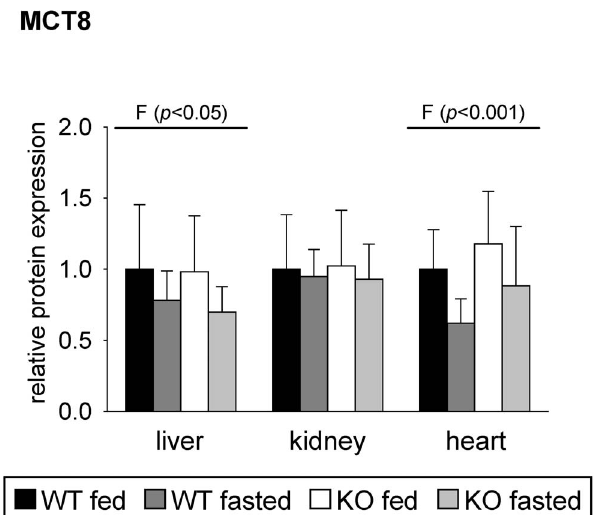
Figure 6. Relative protein expression of monocarboxylate transporter (MCT)-8 in mouse tissues in response to fasting and PPAR a . Values represent means 6 SD of relative protein expression of wildtype (WT) and PPAR a knockout (KO) mice that were fed ad libitum or fasted for 48 h (n=16). Data were analyzed by two- way ANOVA. Classification factors were genotype, fasting, and the interaction between both factors. P -values revealed by two-way ANOVA are noted above the figures. Individual means of the treatment groups were compared by Tukey’s test in case of variance homogeneity. In case of variance heterogeneity, as revealed by Levene’s test, individual means were compared by Games Howell test. No significant differences in post-hoc comparison were